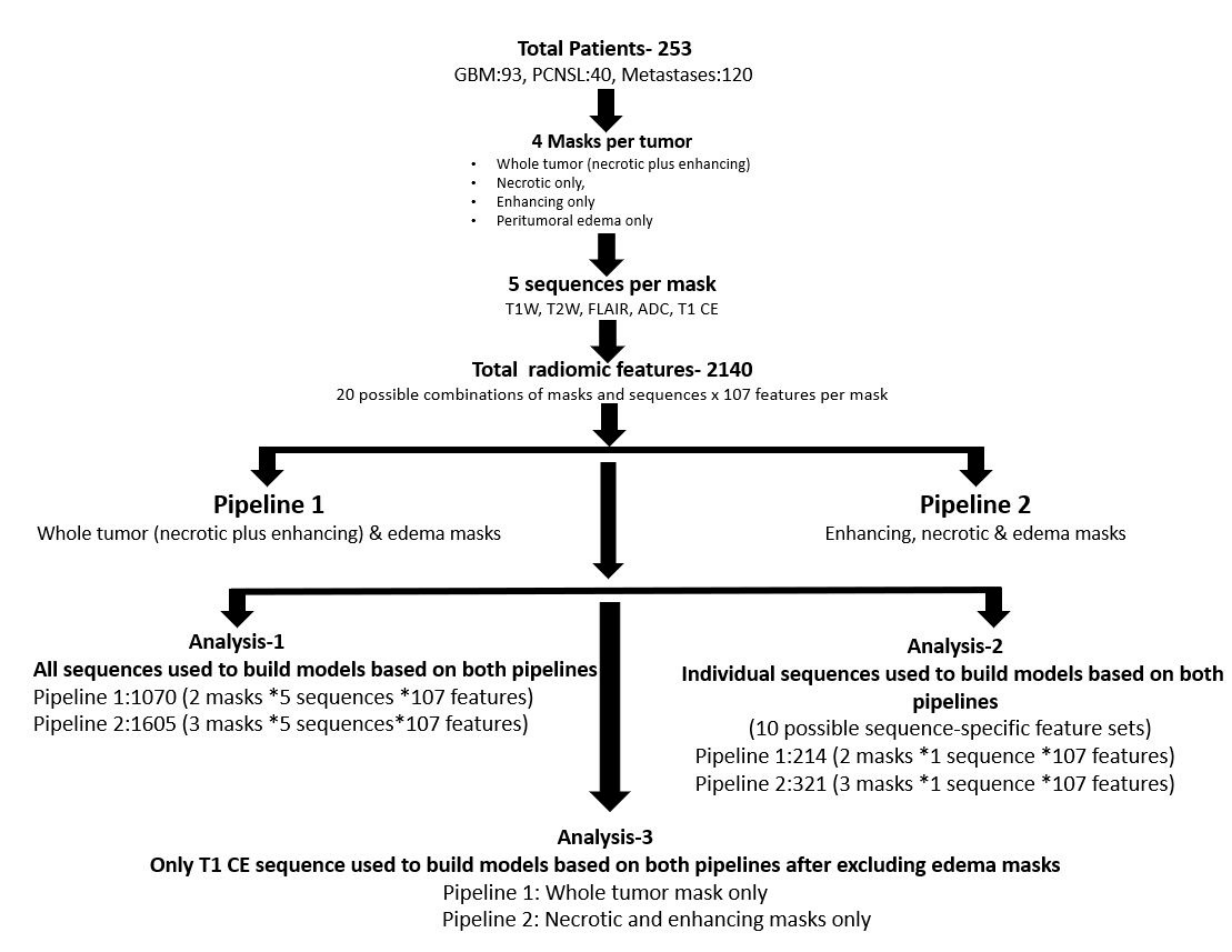
Figure 3. Primary and subgroup analysis workflow of both pipelines.